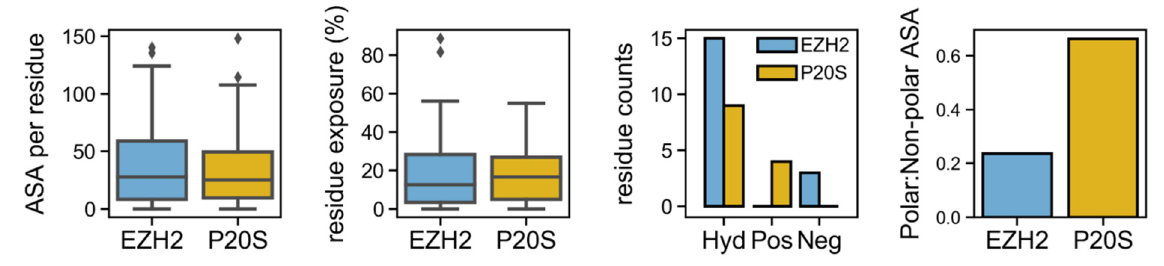
Figure 5. Assessment of accessible surface of binding pockets in EZH2 and P20S ( β 5 pocket). ASA is defined as the accessible surface area (Å 2 ) and expresses the area around a residue that is exposed to the solvent. Residue exposure measures how much (in %) of a residue’s surface is exposed. Additionally, the number of residues according to type (hydrophobic (Hyd), positive (Pos), and negative (Neg)) is shown and, complementarily to this, the ratio of polar:nonpolar residues is also shown.